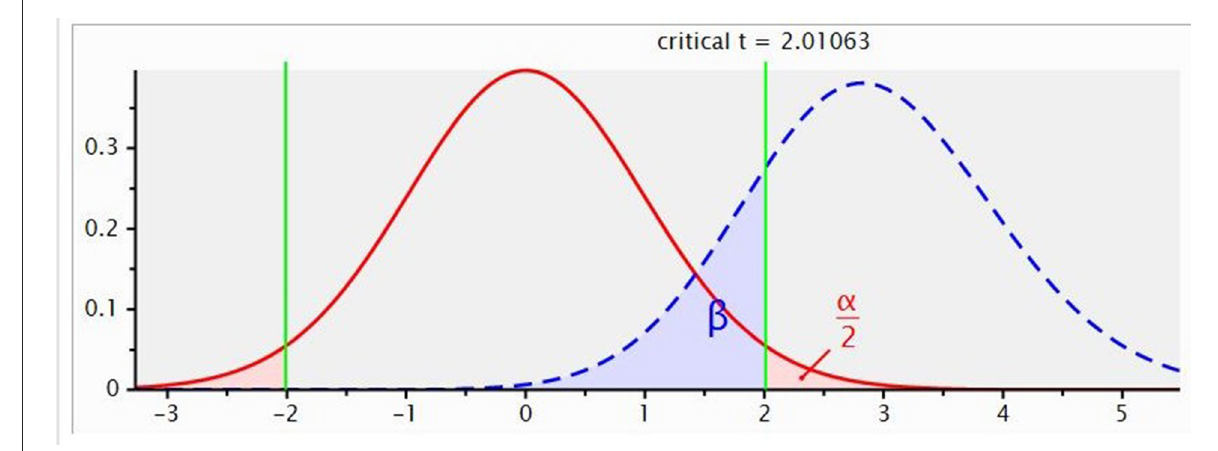
FIGURE1 G-power analysis for statistical power, critical t -value and sample size.